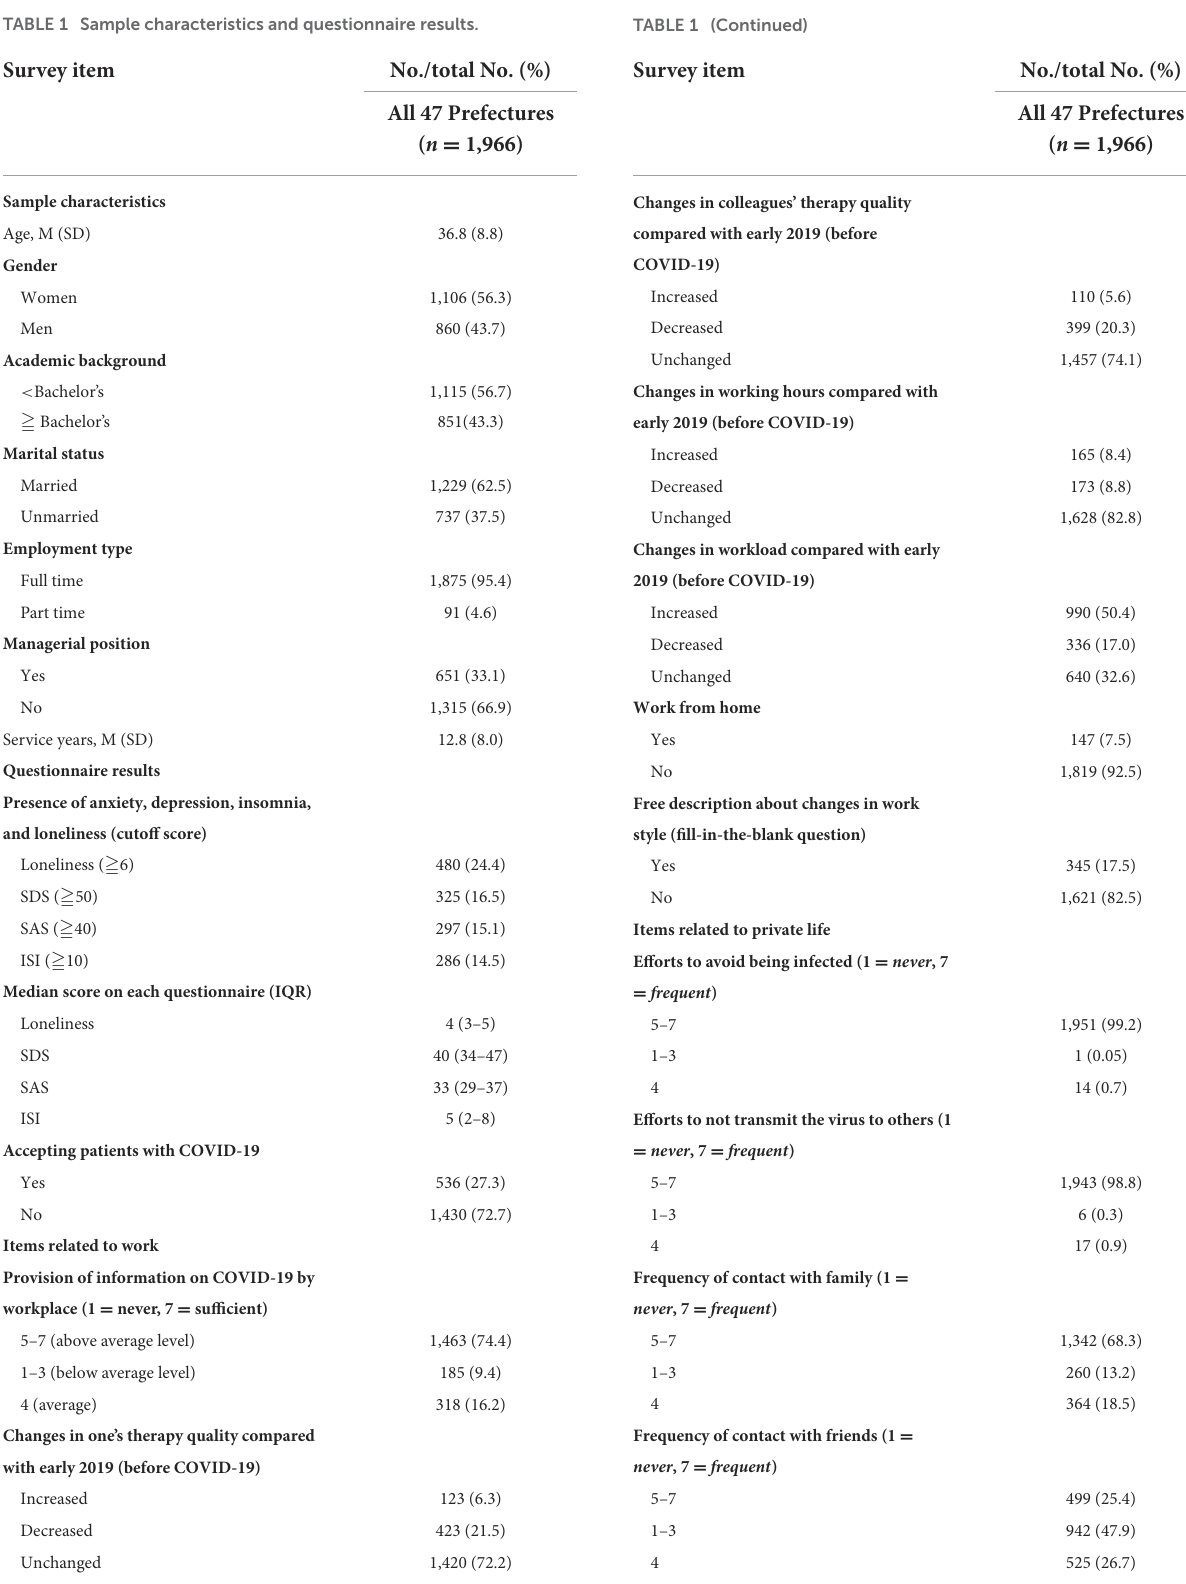
TABLE 1 Sample characteristics and questionnaire